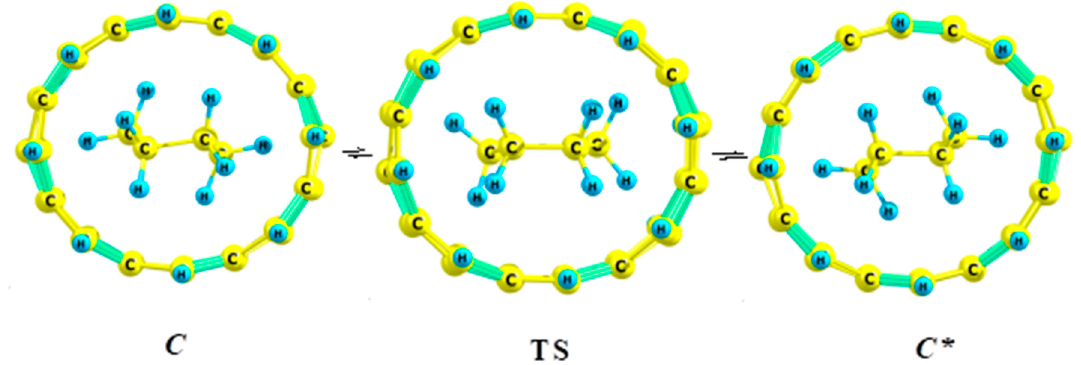
Figure 15. Conformational equilibrium of cyclohexane in cluster C 6 H 12 @(8,0). Adapted with modification [204].